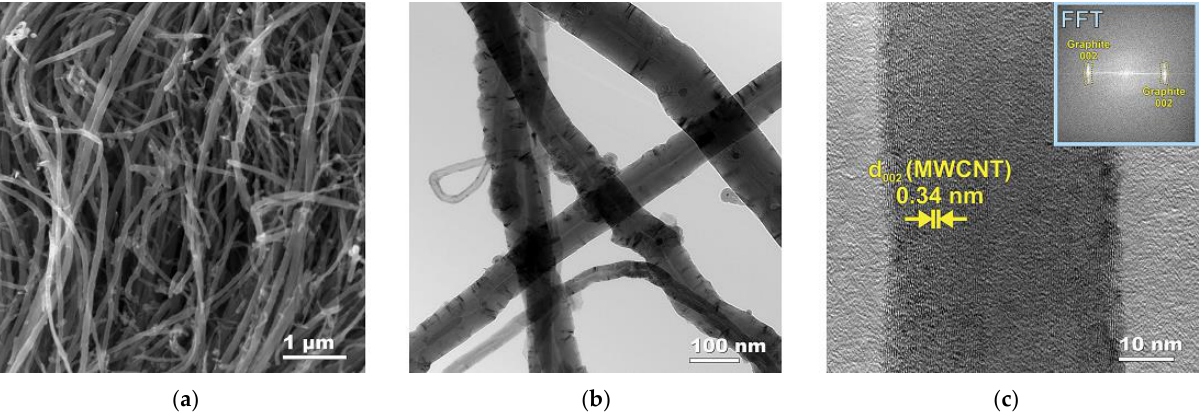
Figure 1. Electron microscopy images of the initial MWCNTs: ( a ) SEM; ( b ) TEM; ( c ) HRTEM of a lonely nanotube with the FFT pattern in insert.